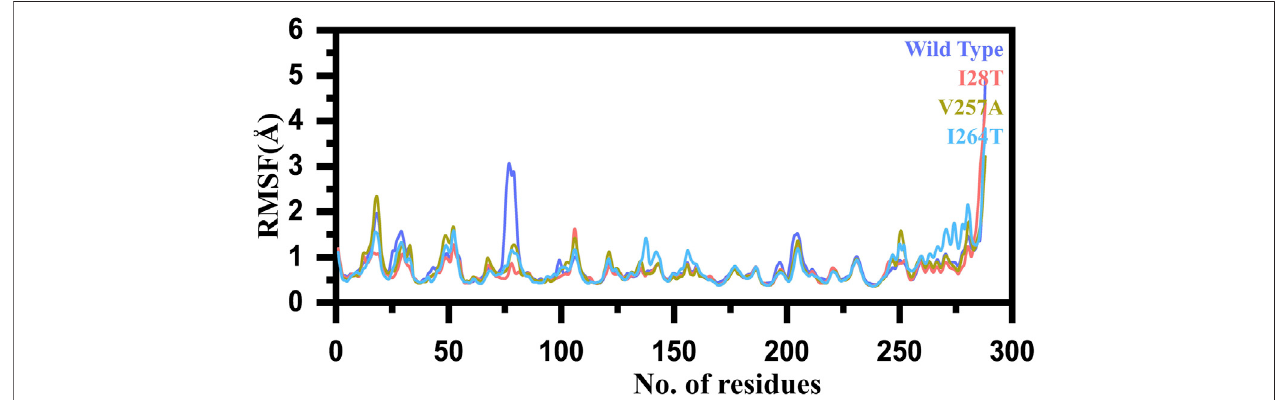
FIGURE 6 | RMSF graph of the WT and mutants (I28T, V257A, and I264S). The x -axis shows the number of residues, while the y -axis shows the RMSF in angstrom.